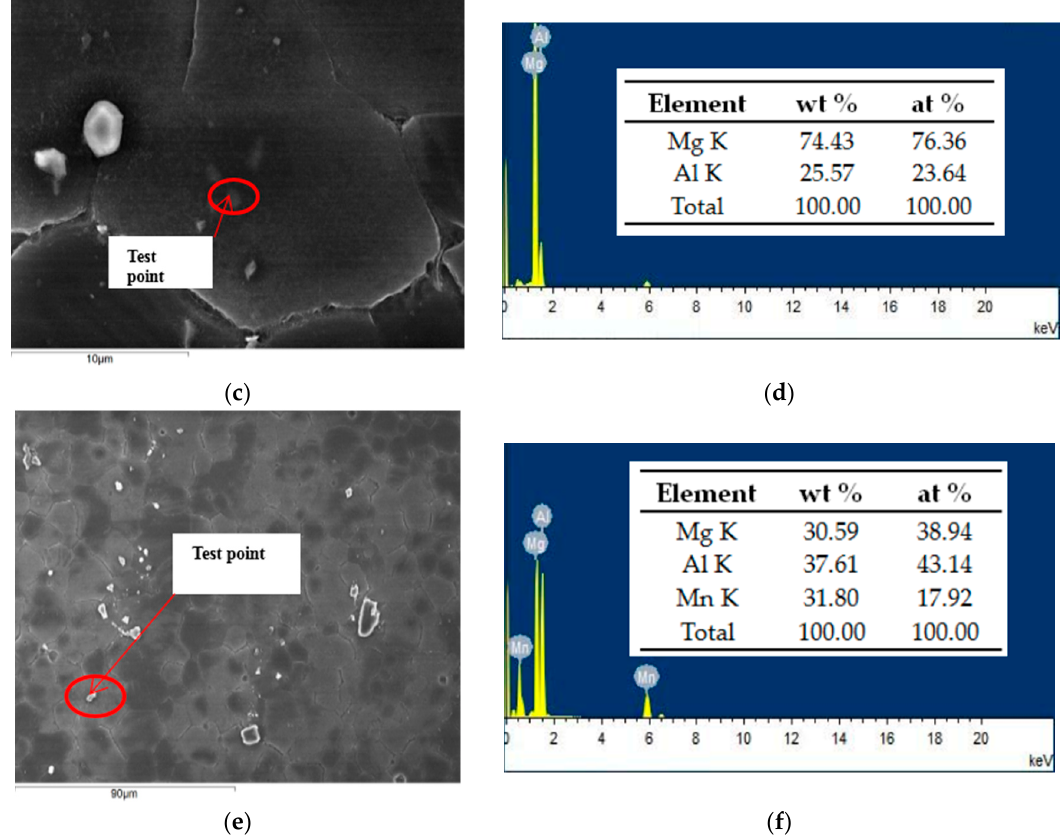
Figure 16. ( a , b ) SEM images of the AZ61/SiCp MMC extruded plates after annealing (10 μ m SiC with 5 wt %) with *300 and *180; ( c , e ) Test point for EDX analysis of the AZ61/SiCp MMC extruded plates after annealing (10 μ m SiC with 5 wt %); ( d , f ) Element results from EDX analysis of the AZ61/SiCp MMC extruded plates after annealing (10 μ m SiC with 5 wt %).